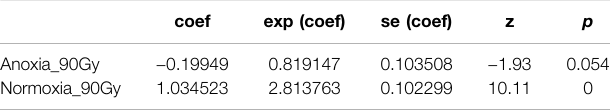
Frontiers in Bioengineering and Biotechnology |